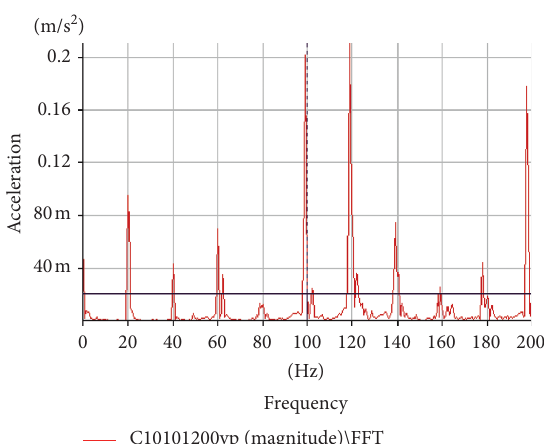
Figure 3: 0.06mm offset, 1200rpm.